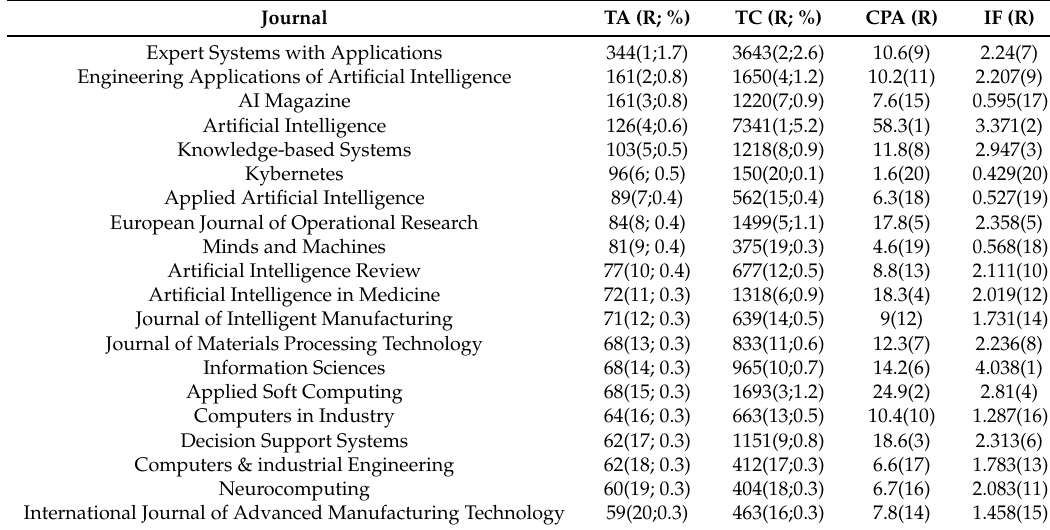
Table 2. Most productive journals in artificial intelligence